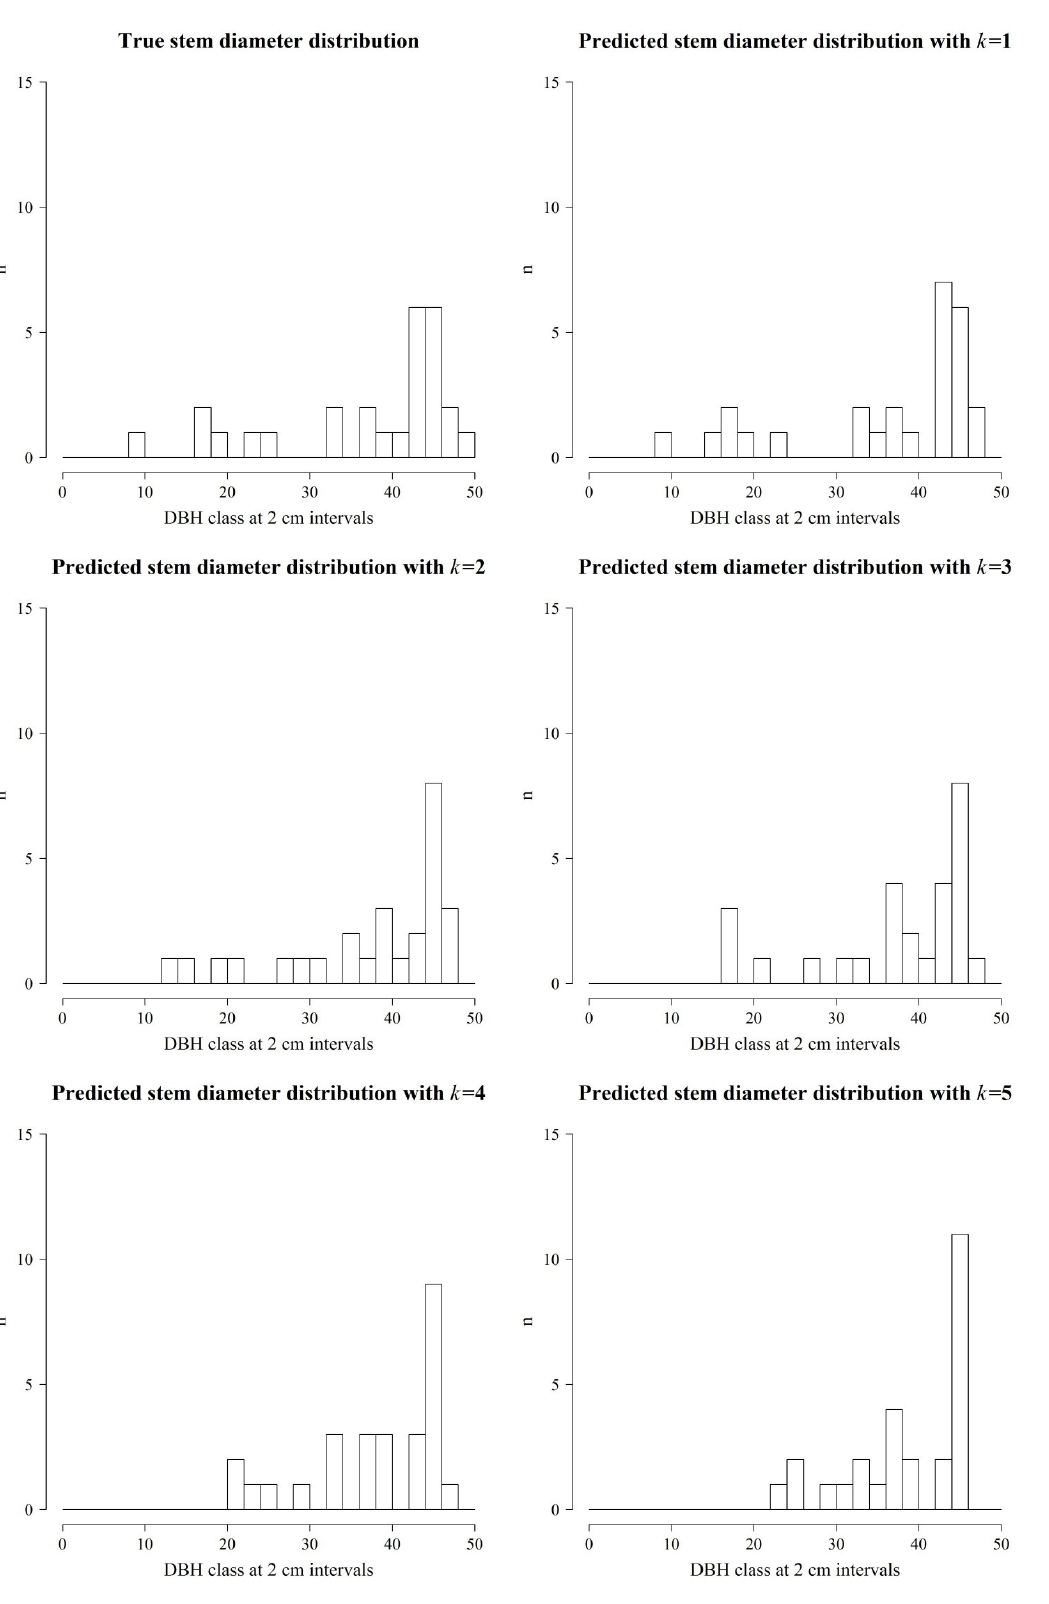
Figure 7. True stem-diameter distribution ( top left ) and predicted stem-diameter distributions with different k values for the park area (northern part of the study